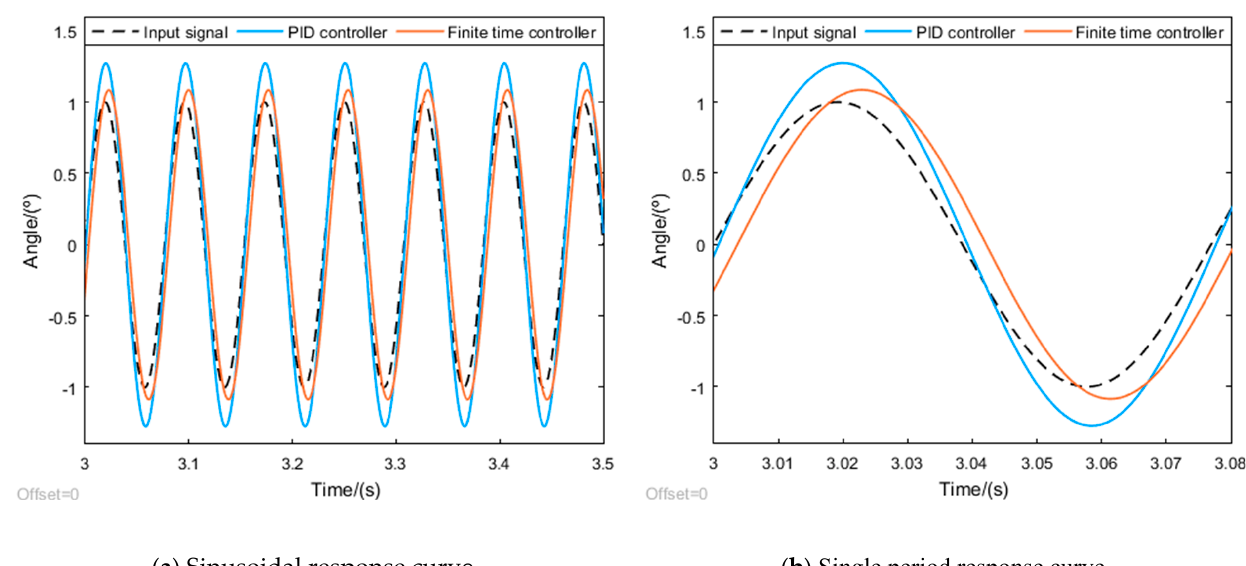
Figure 12. Finite-time composite control response curve of the motor system with 13 Hz and 1° sinusoidal signal.